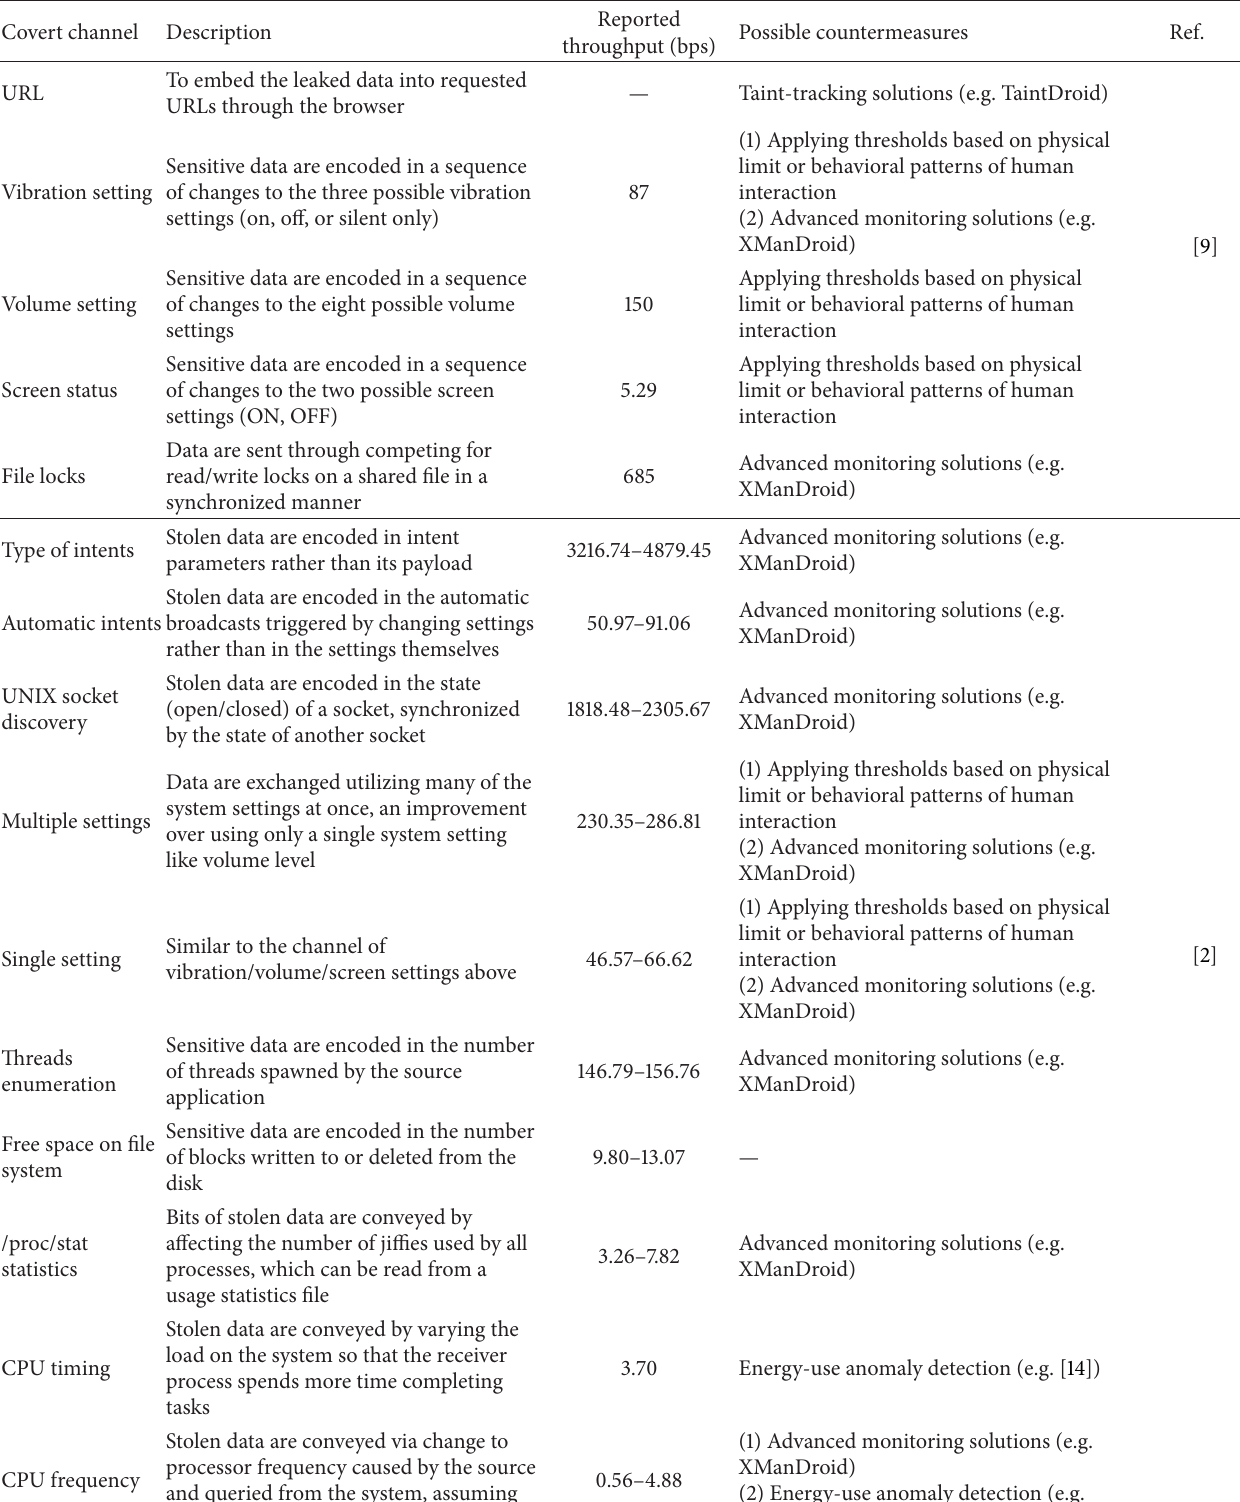
Table 1: Summary of Android covert channels in the